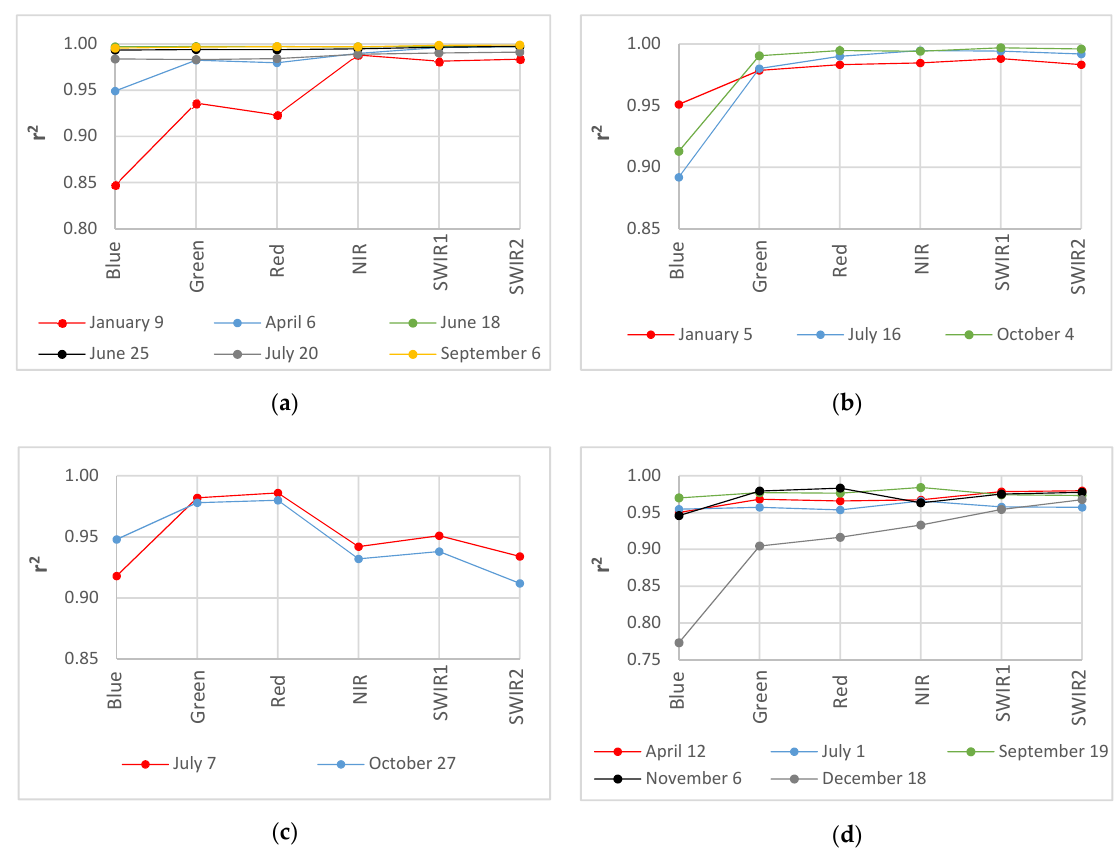
Figure 3. Coefficient of determination (r 2 ) between L8 PANSH and L8 L2 images for the six tested bands and each study site: ( a ) SS1 (Almería); ( b ) SS2 (Agadir); ( c ) SS3 (Bari); ( d ) SS4 (Antalya). All the 100 polygons representing greenhouses were considered in each study site.